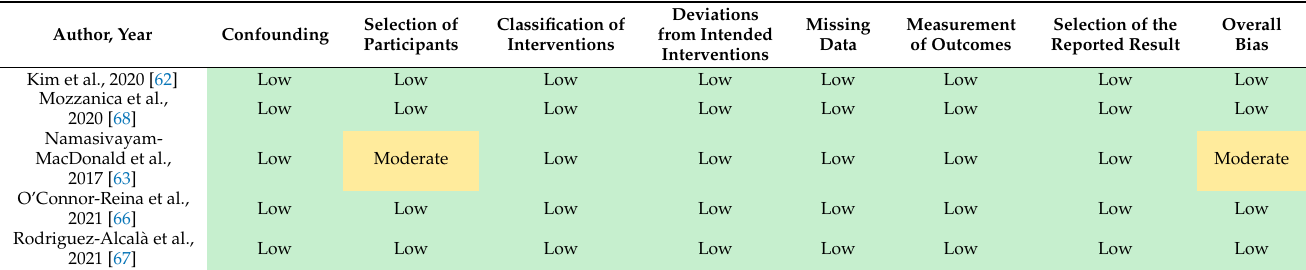
Table 5. Risk of bias assessment of non-randomized studies using ROBINS-I